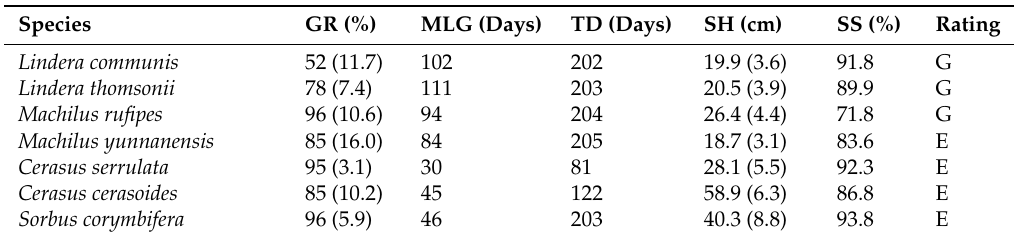
Table 3. Nursery production characteristics for the 21 selected tree species from a subtropical evergreen broad-leaved forest in SW